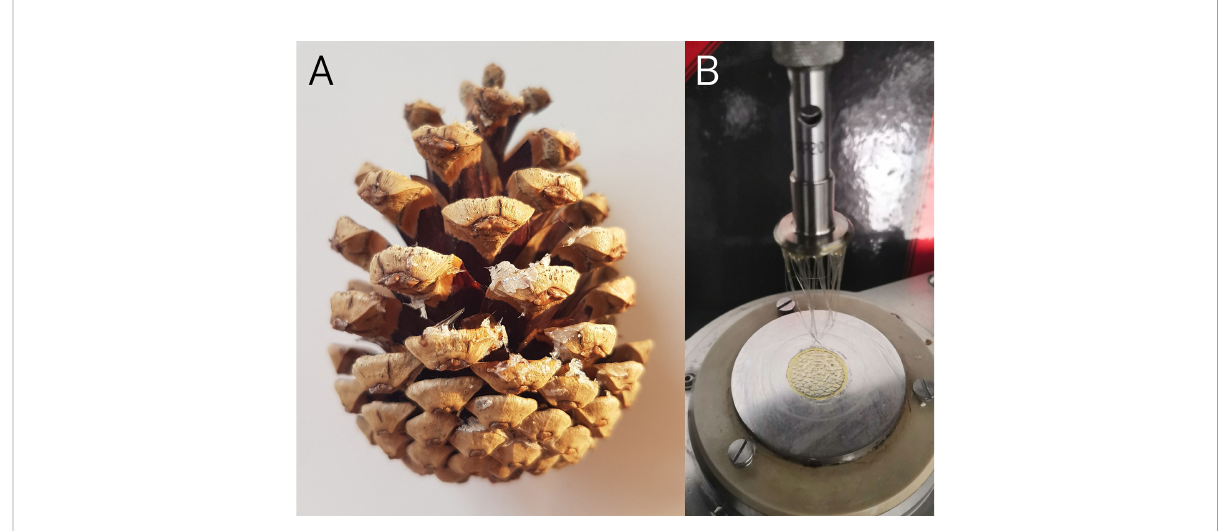
FIGURE 5 Resin threads. (A) Naturally occurring threads of resin between the scales of a P. nigra cone. (B) Experimental resin threads produced during rheological measurements by pulling apart two metal plates glued by resin from P. sylvestris